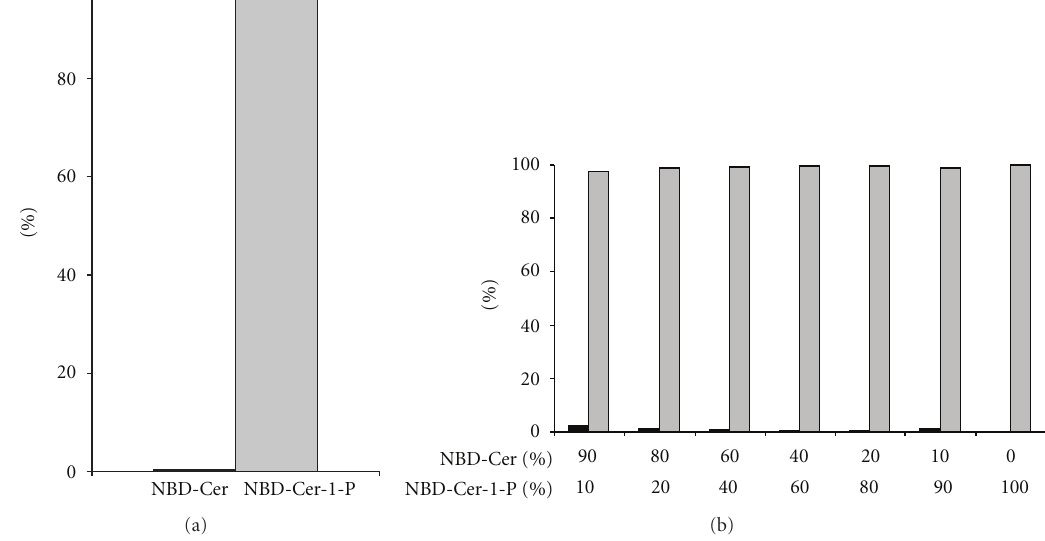
Figure 3: Separation of NBD-C 6 -Cer and NBD-C 6 -Cer-1-P via NH 2 -SPE. A mixture containing NBD-C 6 -Cer and NBD-C 6 -Cer-1-P, both at 5 μ M (a) or at a total concentration of 5 μ M but with a variable ratio (b) in the assay medium was separated via NH 2 -SPE, as described in Section 2. The eluted fractions were dried, resolubilized in chloroform/methanol (1/2, v/v) and the lipids were separated on silica G TLC plates (chloroform/acetone/methanol/acetic acid/water, 10/4/3/2/1, v/v), followed by fluorescence scanning of the spots (NBD-C 6 -Cer (black bars); NBD-C 6 -Cer-1-P (grey bars).) The result is expressed as percentage of total fluorescence in the elution fraction (a) mean ± SEM; n = 5; (b) single